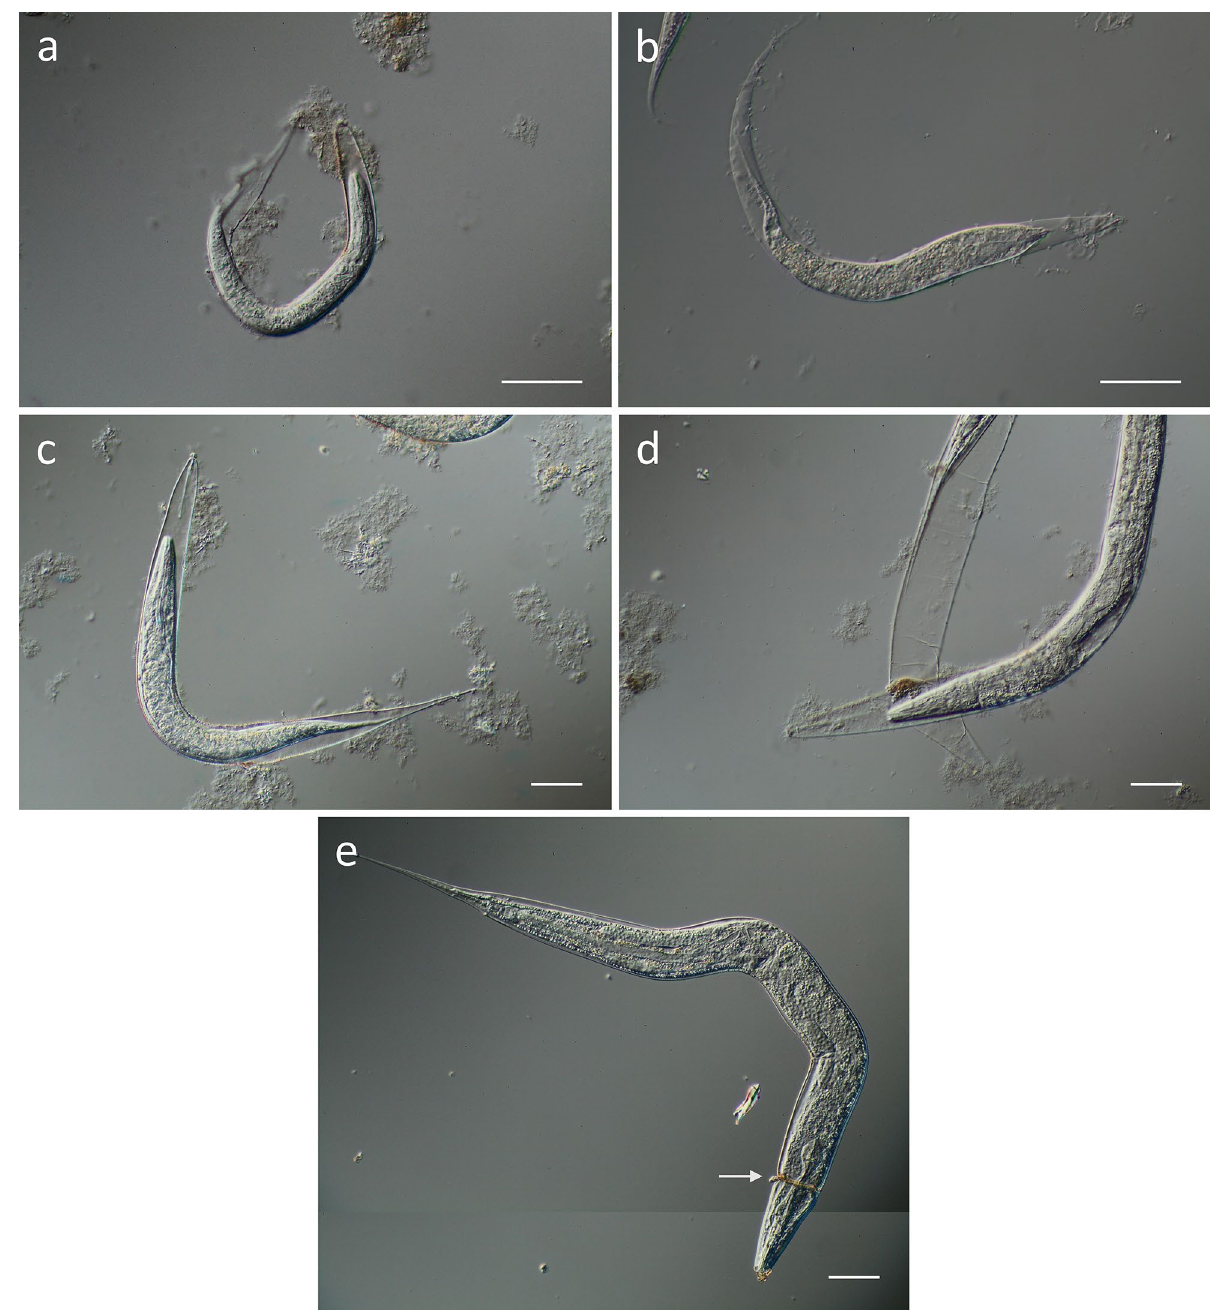
Figure 5. DIC microscopy of different larval stages of C. elegans treated with CM (2 mg/mL) overnight. ( a ) L1 larva, ( b ) L2 larva, ( c ) L3 larva, d ) L4 larva, each entrapped within the unshed cuticle. ( e ) L4 larva with partially shed cuticle causing a constriction in the head region. Scalebar 50